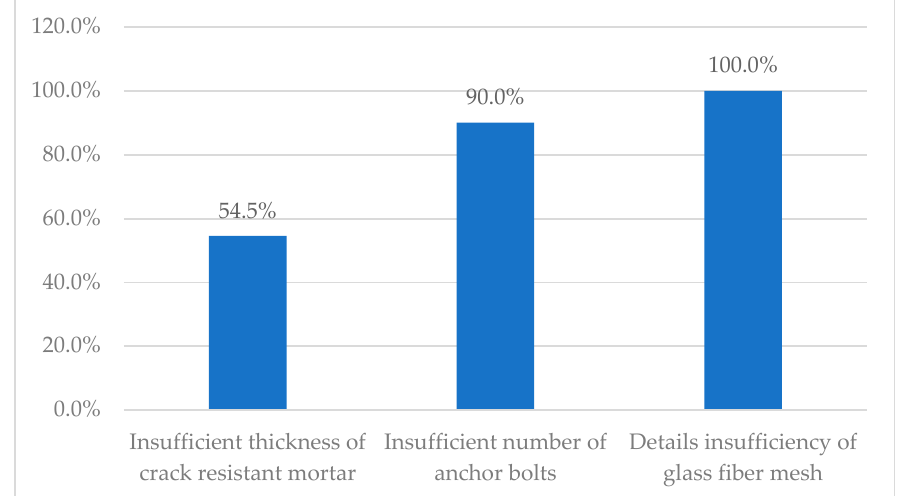
Figure 14. Proportion of detail insufficiencies in total number of detection buildings.